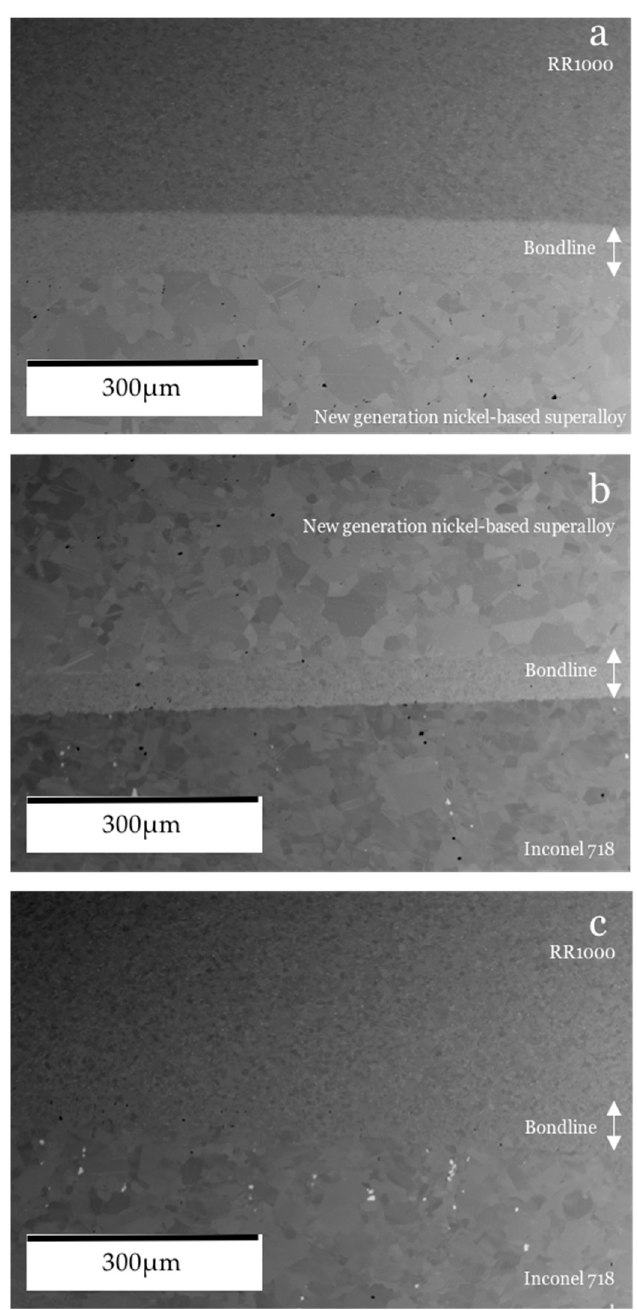
Figure 6. SEM BSE of bonds: ( a ) bond 1, ( b ) bond 3, ( c ) bond 3 .